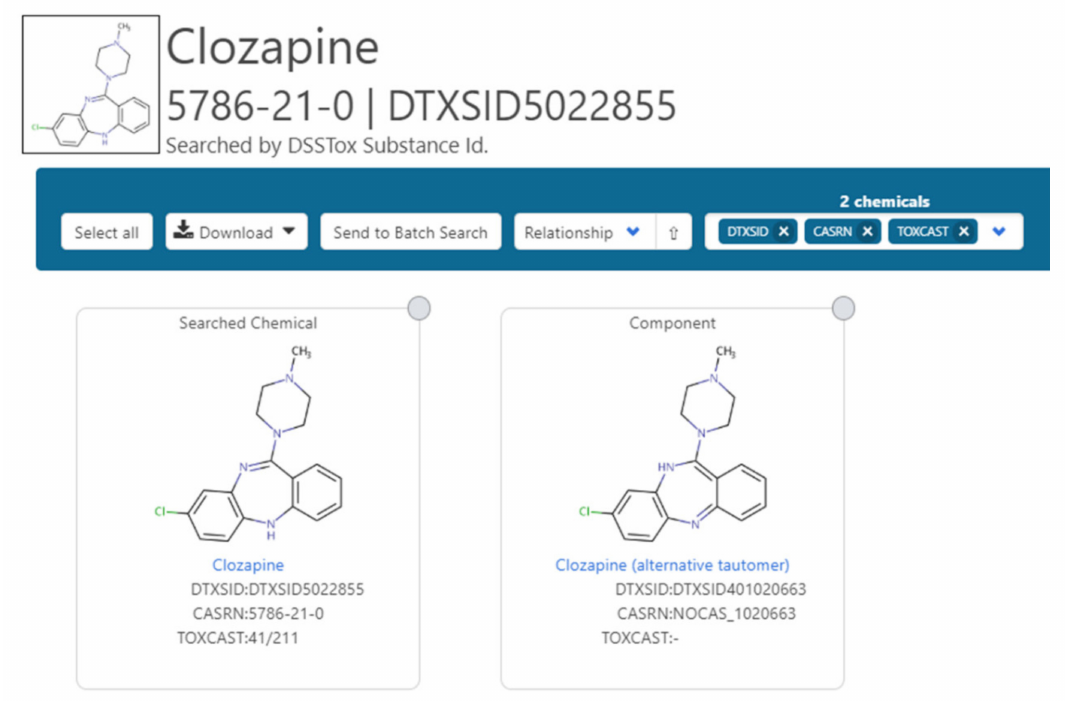
Figure 2. The two tautomers of clozapine registered in the database. This is possible because the data do not collapse based on standard InChIKeys. They are mapped against each other as related